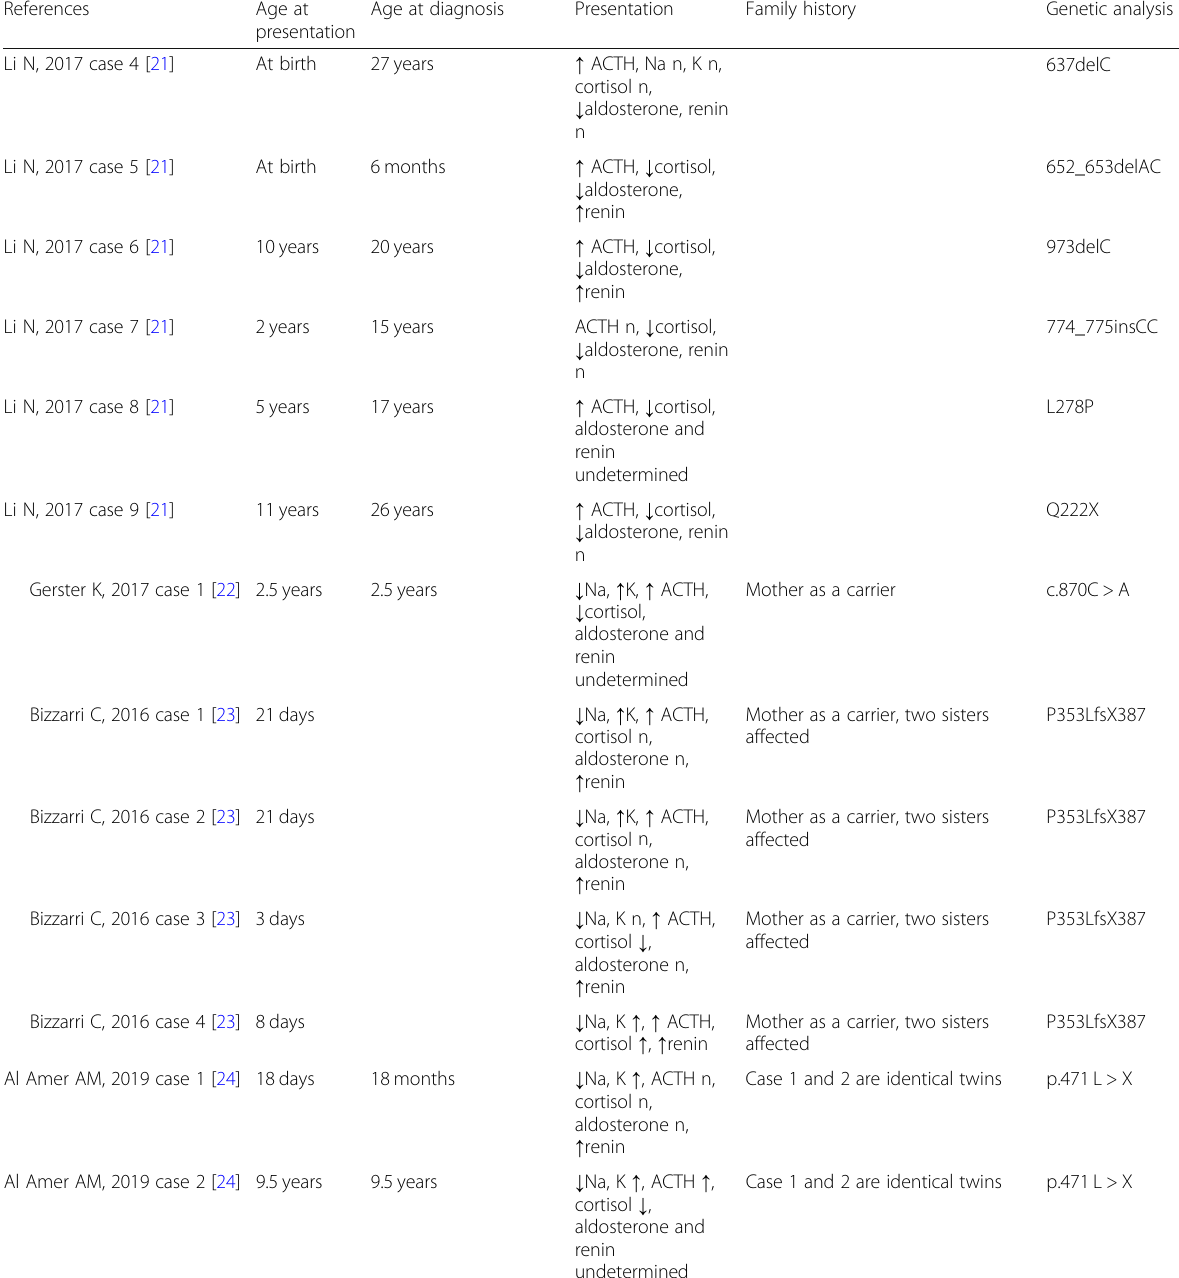
Table 2 Recent cases of ACH described in literature: main clinical and genetic characteristics